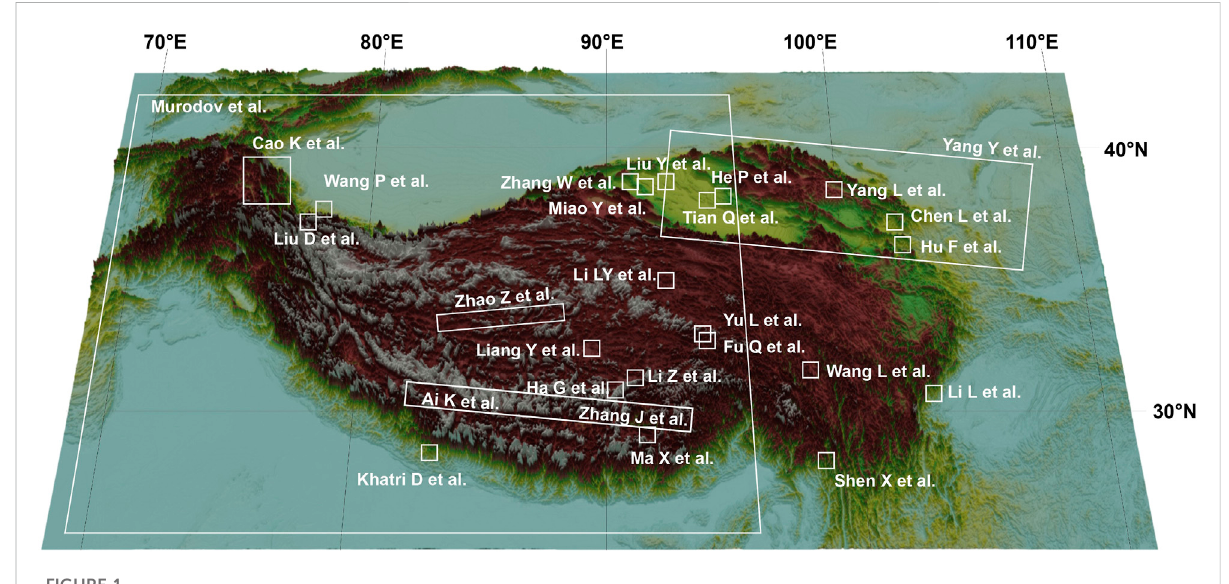
FIGURE 1 Locations of publications of this Research Topic on the Tibetan Plateau and surrounding